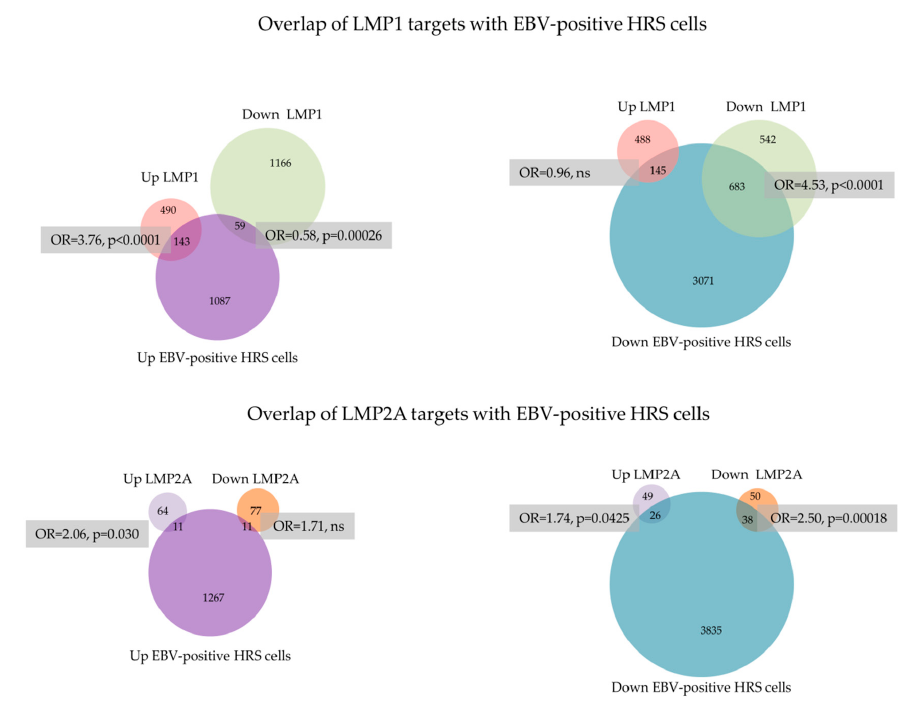
Figure 4. Overlap of LMP1 and LMP2A targets with EBV-positive HRS cells. Genes differentially expressed following transfection of normal GC B cells with either LMP1 or LMP2A were compared with those differentially expressed in EBV positive HRS cells. Statistical significance of overlap between gene sets was determined using Chi-square test.